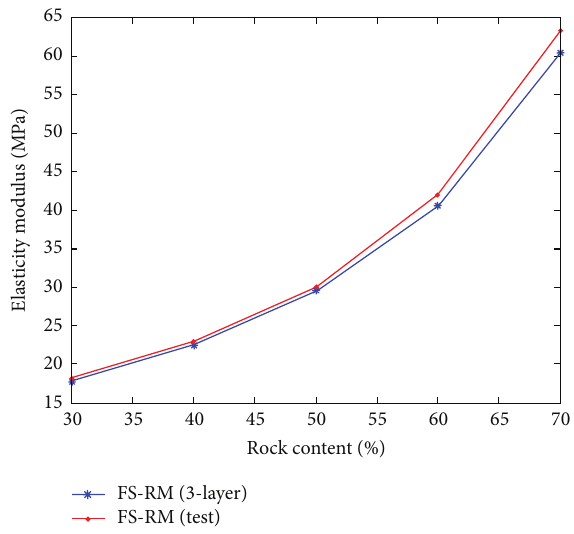
Figure 12: Comparison between values calculated by the soil-rock mixture model and experimental values at freezing temperature